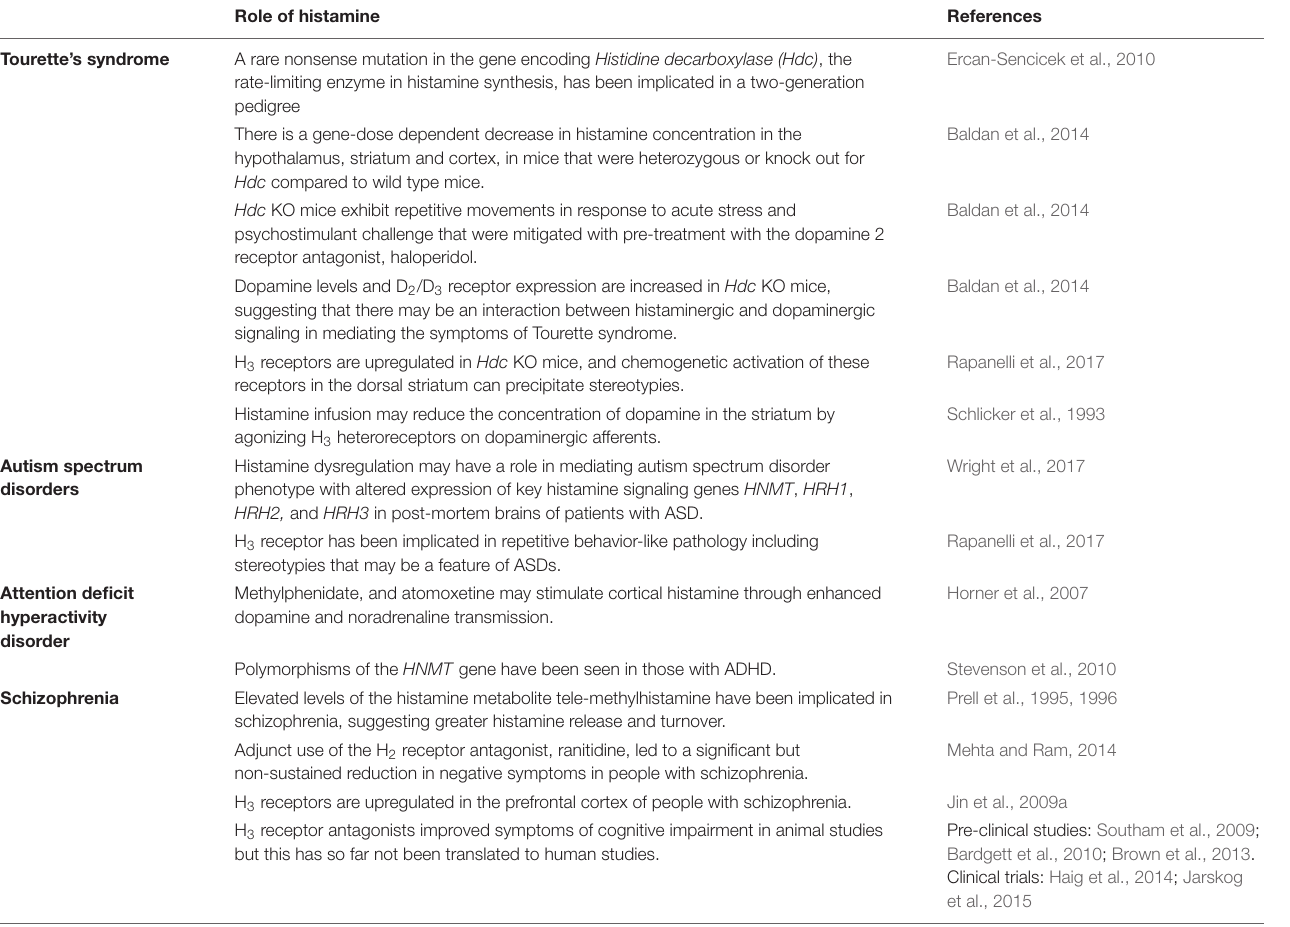
TABLE 2 | The role of histamine in the aetiology of neurodevelopmental